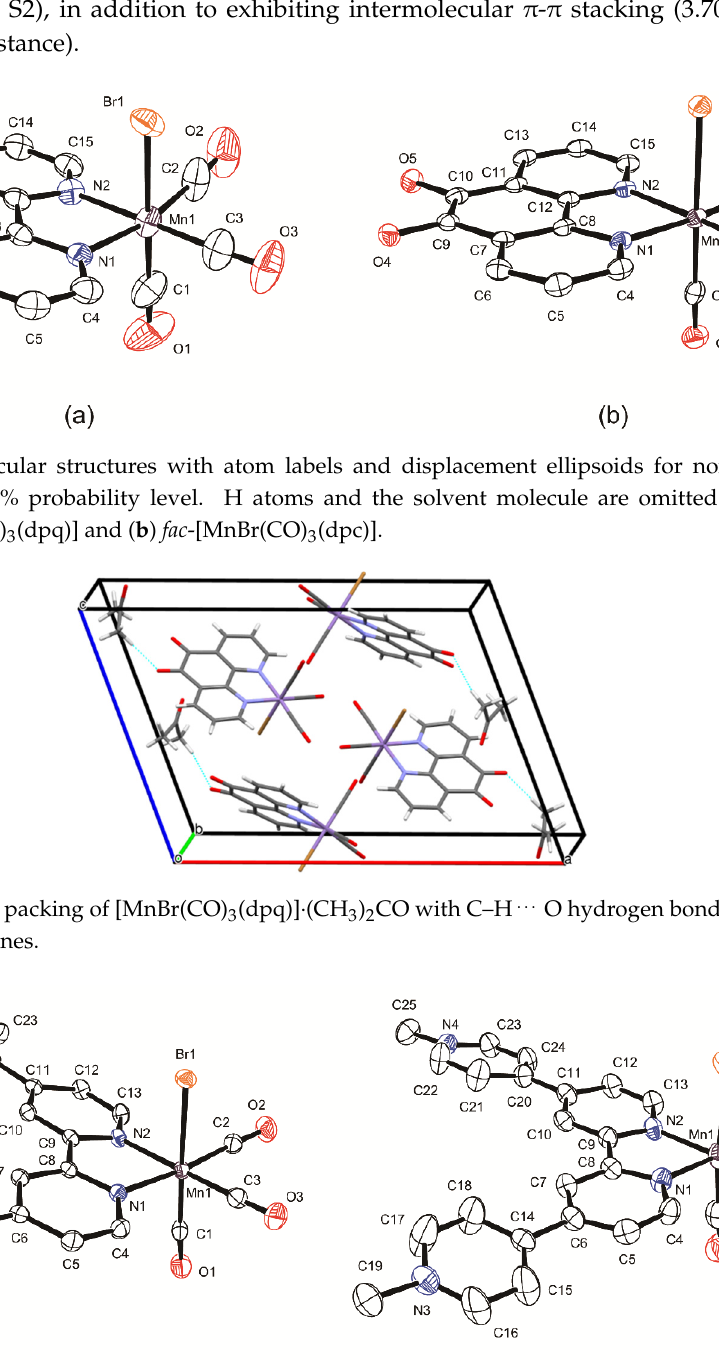
Figure 6. Crystal packing of [MnBr(CO) 3 (dmqpy)]Br(PF 6 ) with the C–H … Br hydrogen bonds indicated by blue dashed lines. 2.3. Redox Properties of the Tricarbonylmanganese Complexes 2.3.1. Phenanthroline-Based Complexes: Interconversion Between Quinone and Catechol Units In the reference Mn-phen , two irreversible one-electron reductions and an oxidation wave were observed. These reductions rapidly led to the loss of bromide, followed by dimerization on the timescale of the cyclic voltammetry (CV) measurements [13]. In contrast, the electrochemical behaviors of Mn-dpq and Mn-dpc differed significantly. Initially, CV measurements were performed on Mn-dpq containing the quinone unit; either acetonitrile or a dilute aqueous HClO 4 solution as a proton source were used as the solvent for carrying out the CV measurements. As previously reported, an irreversible oxidation wave ( E pa = 0.74 V) attributed to Mn II/I was observed, in addition to two reversible redox pairs ( E 1/2 = − 0.58 and − 1.19 V) under aprotic conditions (Table 3 and Figure 7a) [13]. These successive waves were attributed to the stepwise electron transfers between quinone and the catecholate dianion via the semiquinone anion radical (Scheme 3) [13,35]. These potentials are shifted towards more positive values (210 – 350 mV) than those of the free ligand (dpq) due to complexation with the {Mn(CO) 3 } + moiety [13]. When two equivalents of protons were added to the solution, a new reduction wave, in which two sets of redox pairs were united, appeared at a more positive potential ( − 0.2 V), and small oxidation waves were observable on the anodic scan after the reduction (i.e., at 0.27 and 0.43 V) (Figure 7b) [36]. This result suggests that proton-coupled electron transfer (PCET) occurs upon the addition of protons to generate the corresponding catechol unit directly by 2e − /2H + transfers, as shown in Scheme 1a. On the other hand, in the CV of Mn-dpc , which